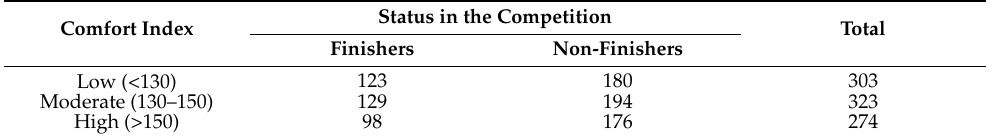
Table 1. Number of horses that participated in the races according to the comfort index (CI) in 34 competitions carried out between March and November across different locations in Uruguay. Comfort Index